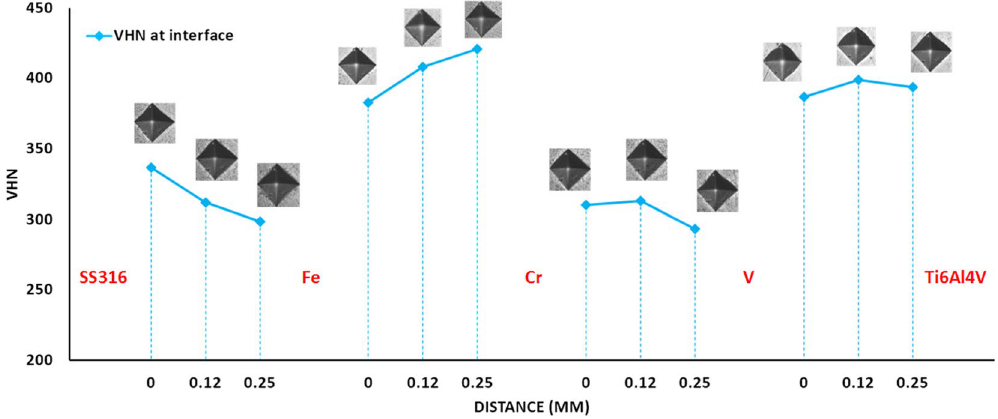
Figure 16. Vickers hardness results at the